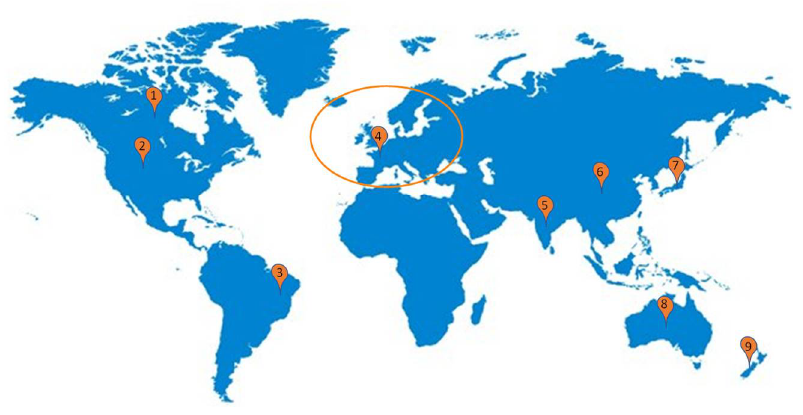
Figure 2. General probiotics regulatory guidelines reference worldwide: America (1, 2, 3); Europe (4); Asia (5, 6, 7); Oceania (8, 9).